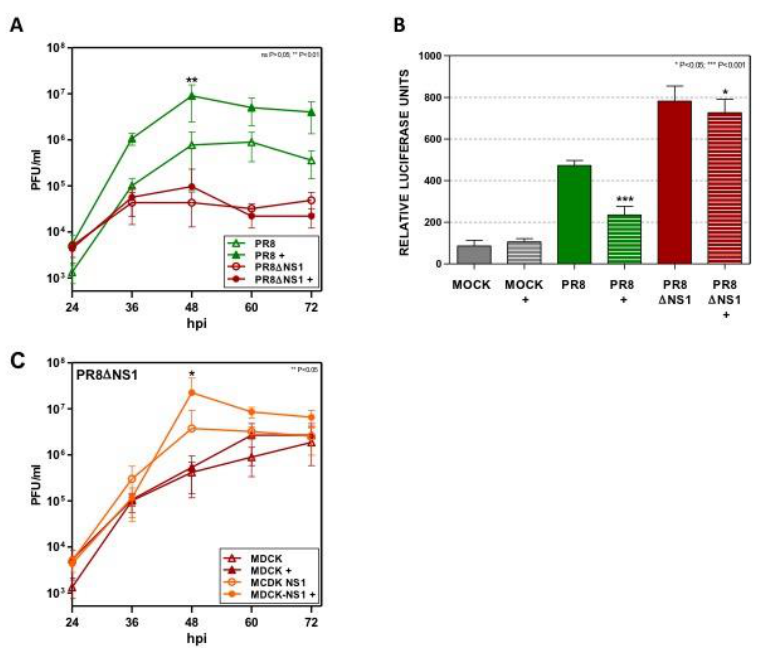
Figure 4. Dot1L does not a ff ect viral replication or IFN- β promoter stimulation in delNS1 virus infected cells. ( A ) A549 cells were plated in the presence or absence of EPZ 1 µ M and 48 h later they were infected at MOI 10 − 3 with PR8 or delNS1 (PR8 ∆ NS1). The virus titer was determined with a plaque assay on MDCK cells. ( B ) A549 cells were left untreated or treated with 1 µ M Dot1L inhibitor ( + ) and 48 h later they were transfected with the plasmid pIF-LukTer. At 24 h post-transfection, the cells were left uninfected (MOCK), or infected with influenza virus (PR8) or delNS1 virus (PR8 ∆ NS1) at MOI 1 and the luciferase activity was evaluated 16 h later. The luciferase activity normalized by Renilla luciferase in the MOCK condition without EPZ treatment was taken as 100%. ( C ) MDCK or MDCK-NS1 cells were plated in the presence or absence of EPZ 1 µ M and 48 h later they were infected at MOI 10 − 3 with delNS1. The virus titer was determined by plaque assay on MDCK cells. EPZ was present all throughout the experiment in the EPZ-treated cells. Three technical replicates of three independent experiments were analyzed. ns p > 0.05; * p < 0.05; ** p < 0.01; *** p < 0.001.